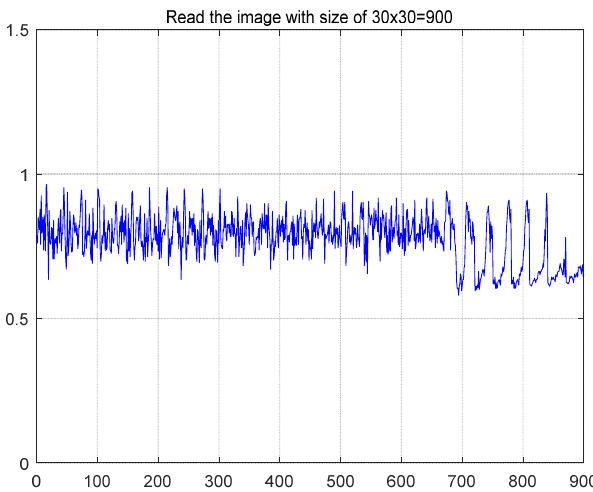
Figure 4. An image is read with a random selection of 30x30 to make 900 points